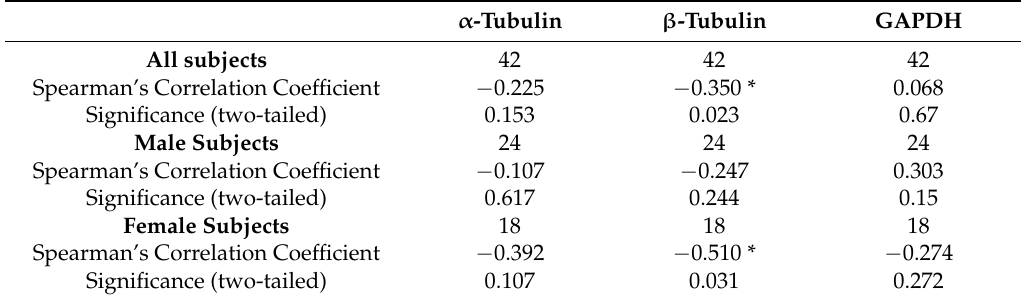
Table 4. Correlation between protein expression level, and sex and age of subjects. α -Tubulin β -Tubulin GAPDH All